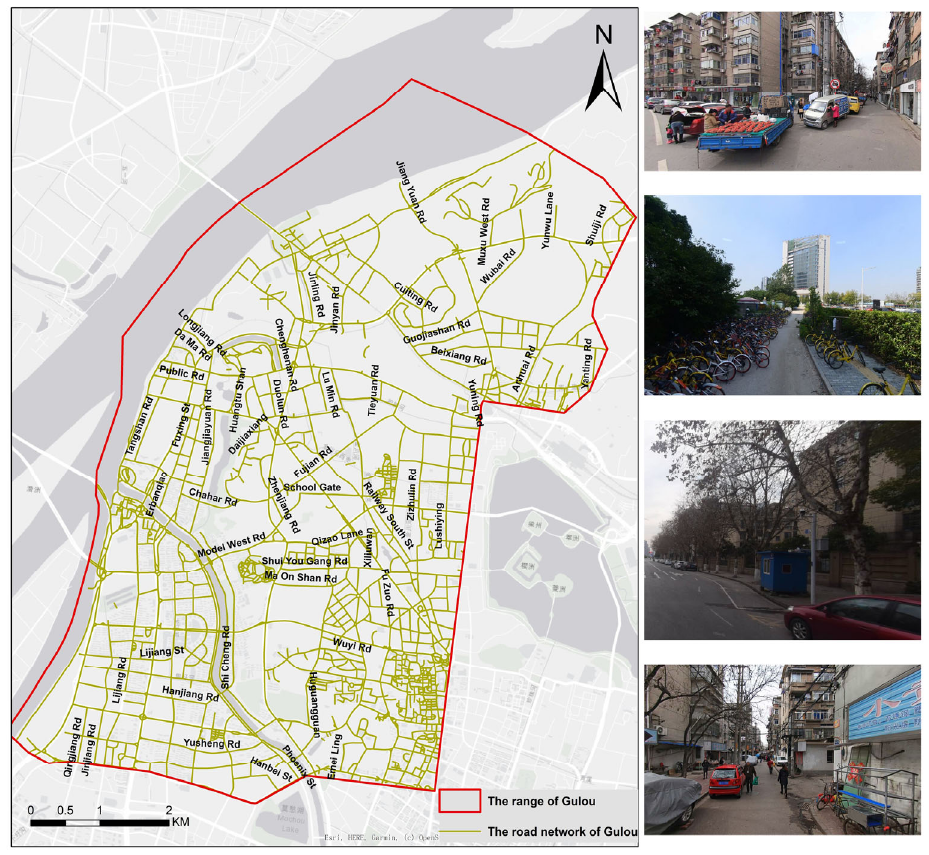
Figure 1. The road network of Gulou District, Nanjing and the common scenarios cropped from street view images.